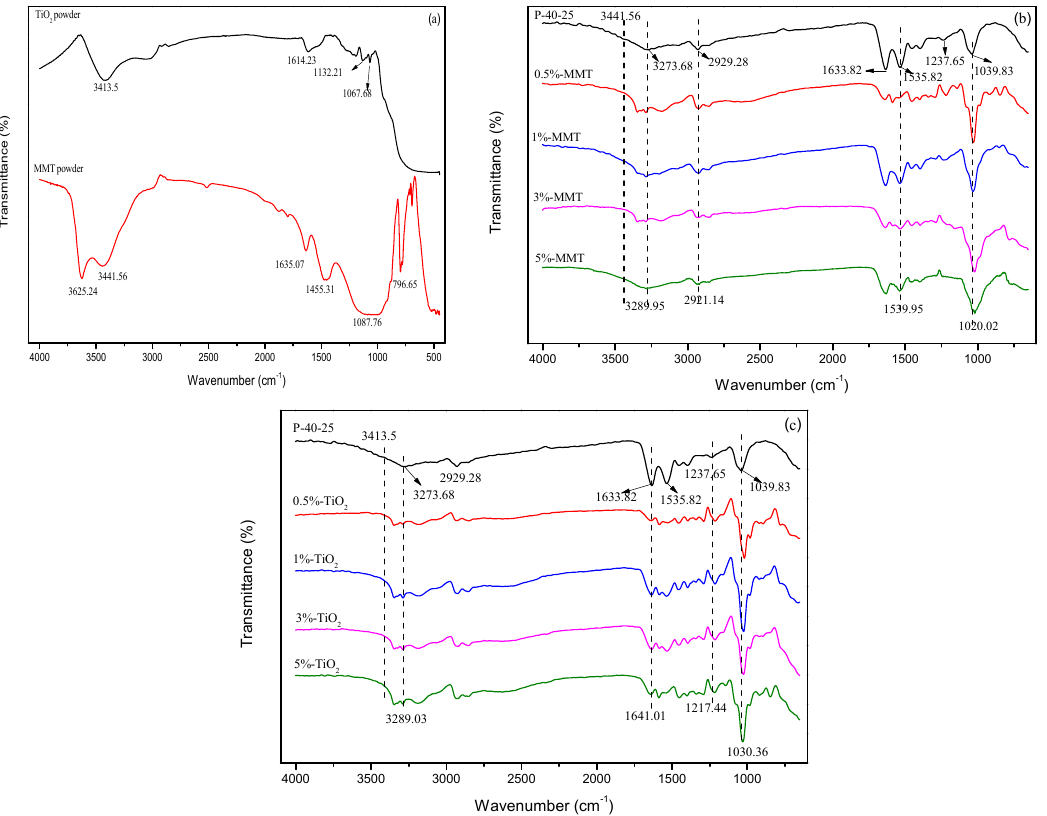
Figure 3. FTIR spectra of ( a ) MMT powder and TiO 2 powder, ( b ) P‐40‐25 incorporated with MMT, and ( c ) P‐40‐25 incorporated with TiO 2 .